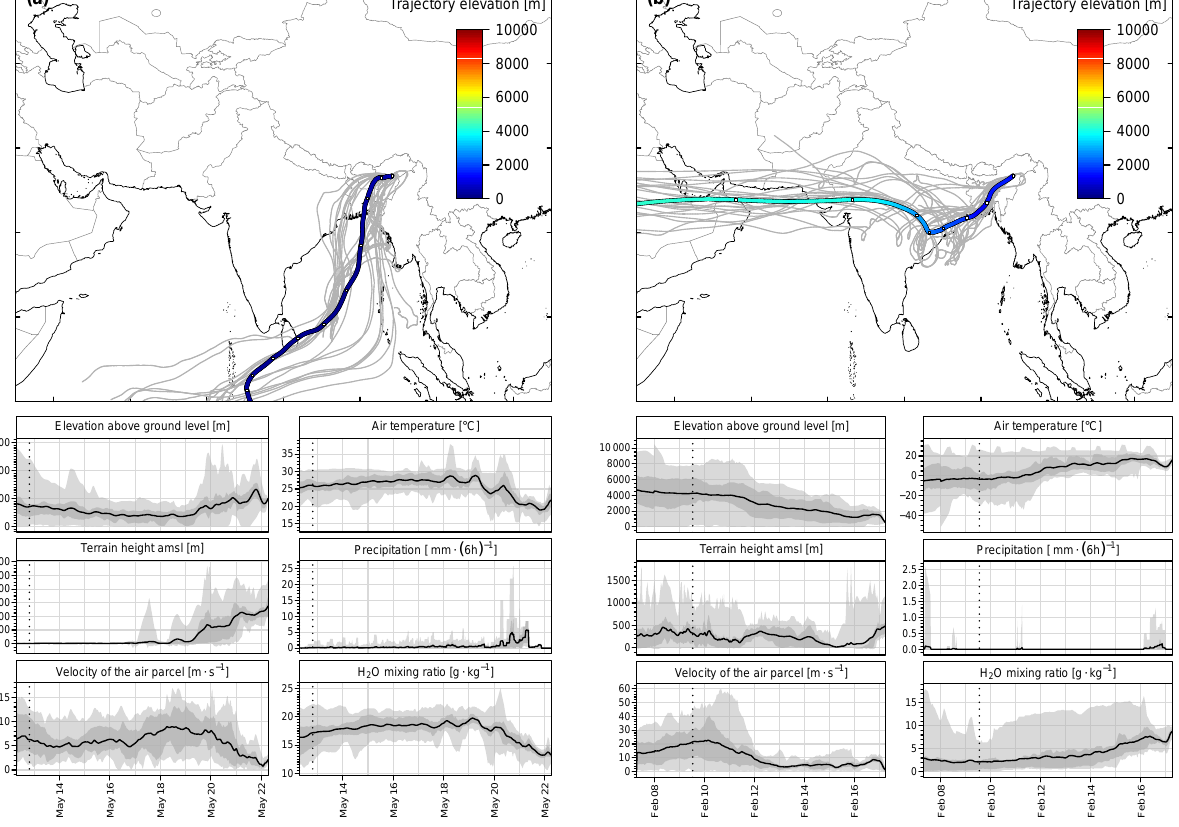
Figure 6. (a) Upper diagram: 10-day backward trajectories arriving at Jorhat station on 22 May 2010, 12:00LT and representing the Indian summer monsoon (ISM) period. (b) Upper diagram: 10-day backward trajectories arriving at Jorhat station on 17 February 2011, 12:00LT and representing the western disturbances (WD) period. Twenty seven ensembles (grey lines in the background) and the mean trajectory (heavy line) are shown. The colours of the mean trajectory indicate elevation above ground level in metres. Empty white dots on the mean trajectory indicate 24h intervals. Lower diagrams of (a) and (b) show the evolution of the six selected parameters of the air parcel along the trajectory. Evolution of the mean value of each parameter is marked with a heavy black line and the associated uncertainty in grey. Dashed vertical lines mark the part of the mean 10-day trajectory visible in the upper diagram. International boundaries are only indicative and as provided by the